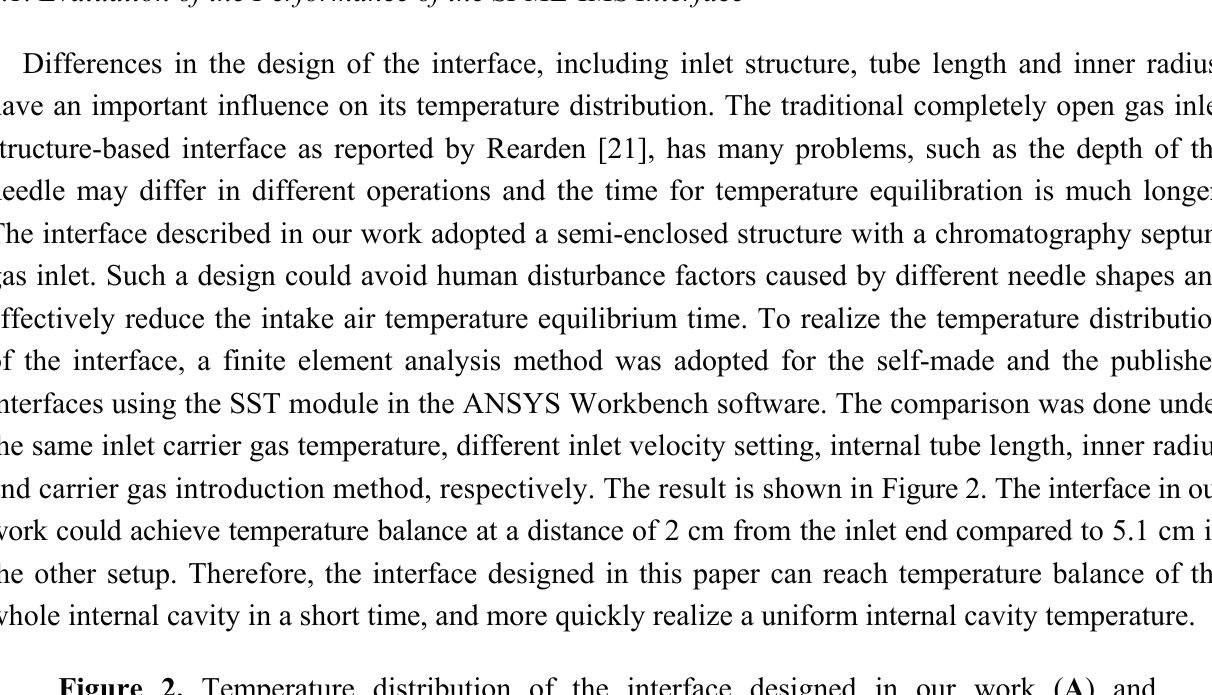
Figure 2. Temperature distribution of the interface designed in our work ( A ) and the published work ( B ). Blue or red colors are presented for the distribution of the different